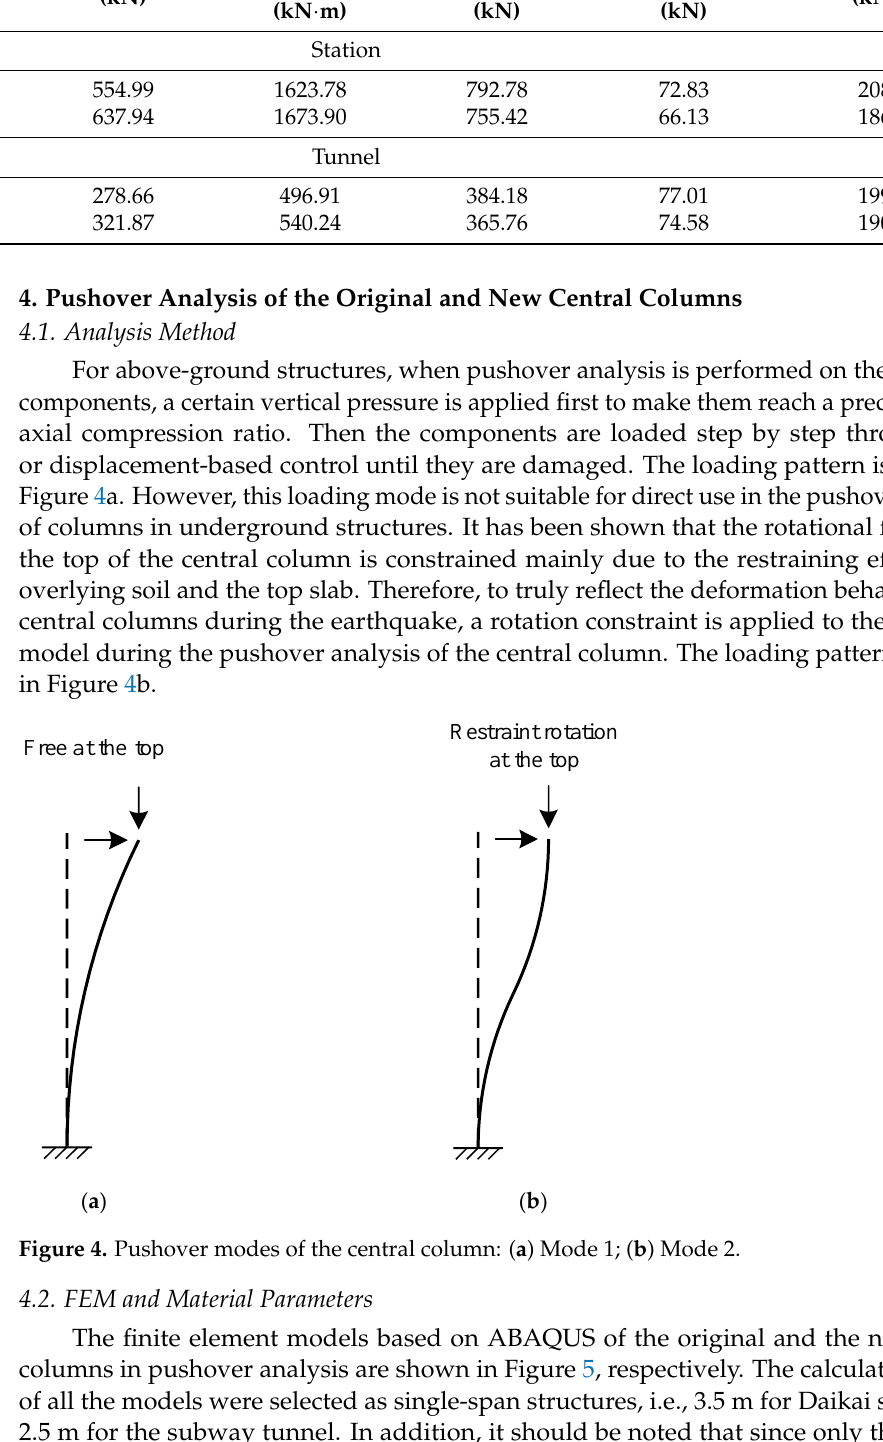
Table 2. Section force of the central column by different analysis methods.